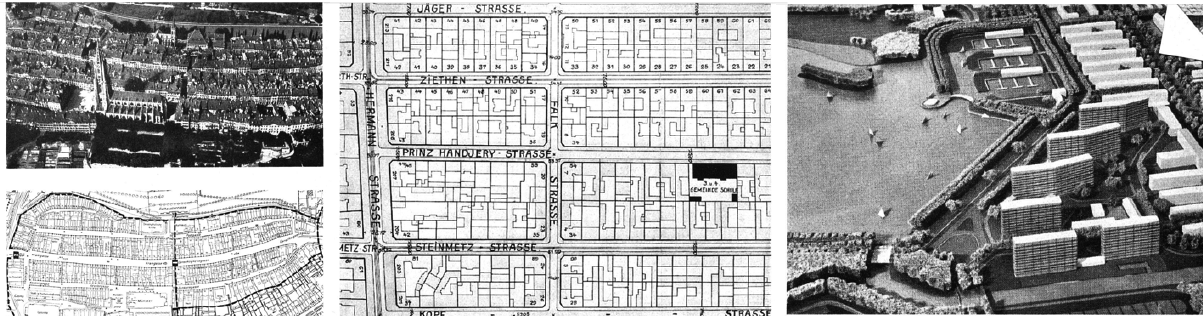
Figure 10. The city and its ground. From left to right: Zähringer foundation, Bern, scope of the plan from 1291 and of the first enlargement; an area with five-storey building construction, Berlin-Neukölln, house after house treated as a single building task, completed by 25 meters high firewalls against the neighbors; Amsterdam. Source: Bernoulli (1946).